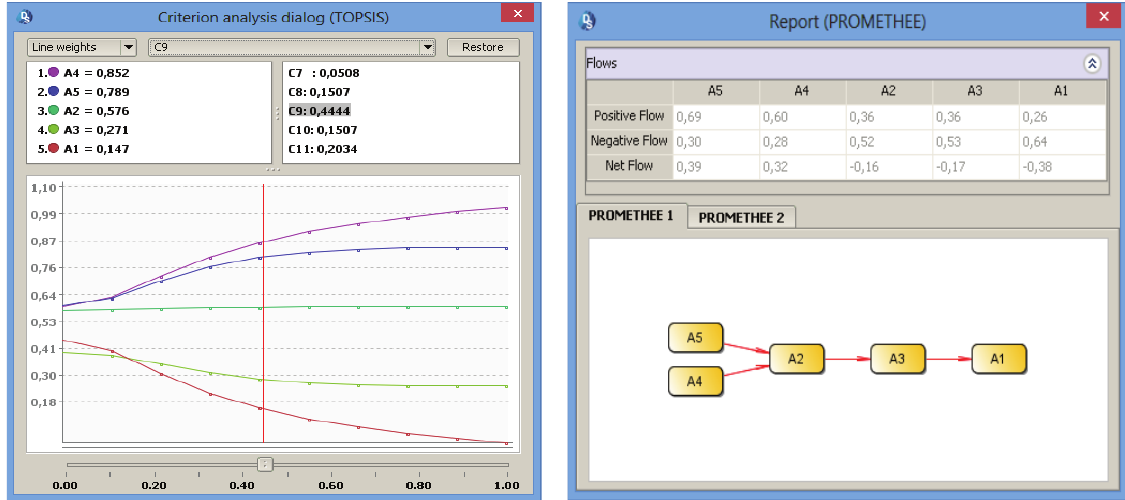
Fig.10. Weight sensitivity analysis in TOPSIS. Fig.11. Ranking alternatives in PROMETHEE-I